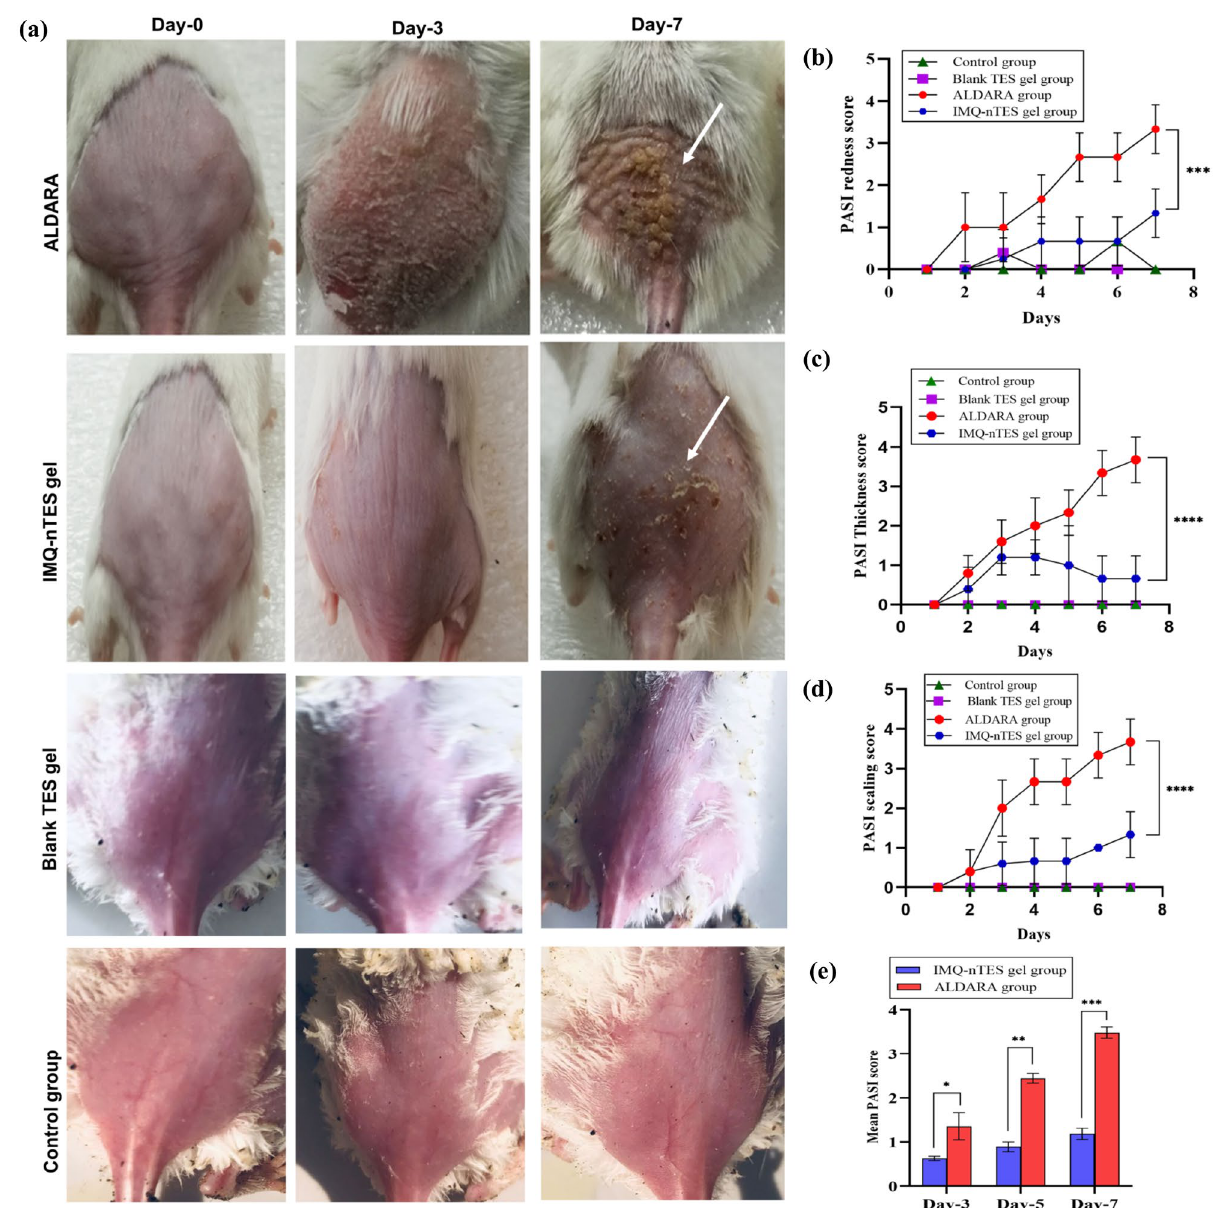
Figure 5. ( a ) IMQ induced cutaneous toxicity in ALDARA and IMQ-nTES gel group. ( b ) PASI redness score of all groups. ( c ) PASI skin thickness score of all four groups. (d) PASI scaling score of all four groups. ( e ) Mean PASI score. All the data is presented as mean ± S.D, n = 3; *p < 0.05, **p < 0.01, ***p < 0.001, ns p > tissues that were seen in the skin micrograph of 0.8% formalin were absent in the IMQ-nTES gel treated skin micrograph, as illustrated in Fig. S2. Cutaneous IMQ concentration assessment. Control and blank TES gel group was shown with no detection of IMQ throughout the 7-day study, however, it was quantified at day-1 in IMQ-nTES gel treated and at day-3 in ALDARA treated BALB/c mice. In the IMQ-nTES gel treated group, the IMQ exhibited 57.47 ± 9.57, 105.59 ± 15.48, 298.55 ± 15.49, and 453.82 ± 22.35, μg/g of striped mice skin at day-1, day-3, day-5, and day-7, respectively. In contrast, at day-1 IMQ was unable to be detected in ALDARA treated group. However, from day-3 to day-7, its level was elevated from 47.312 ± 9.70 to 295.37 ± 13.92 μg/g of striped mice skin. The results are presented graphically in Fig. 4g. At day-7. IMQ conc. was significantly (p < 0.0001) higher among IMQ-nTES treated mice, contrary to the rest of the three experimental groups. PASI clinical scoring of BALB/c mice dorsal skin for psoriatic severity assessment. In Fig. 5a, animals, from all groups, are shown and only ALDARA group animals were manifested with severe psoriatic